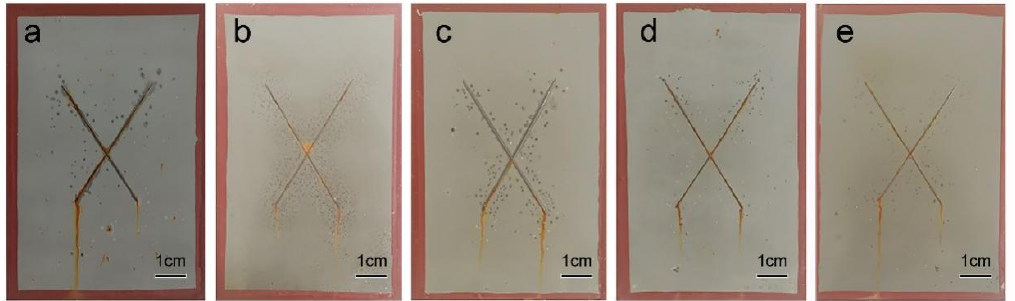
Figure 5. Waterborne epoxy resin coatings exposed to the salt spray test for 300 h. ( a ) WEP; ( b ) DGO10/WEP-05; ( c ) DGO10/WEP-10; ( d ) DGO10/WEP-20; ( e ) DGO10/WEP-30.